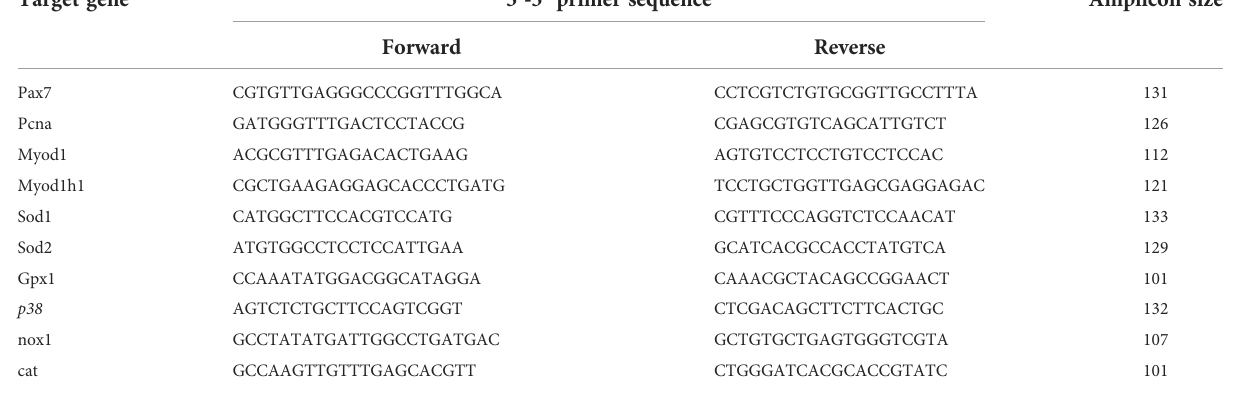
TABLE 3 Primer pair sequences, amplicon size for genes used for real time PCR. Target